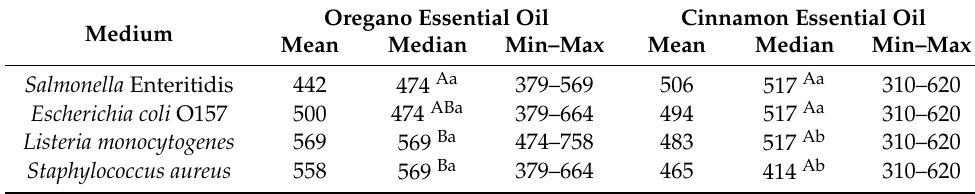
Table 4. Differences in MIC (µg/mL) between various essential oils and pathogens ( n = 18).